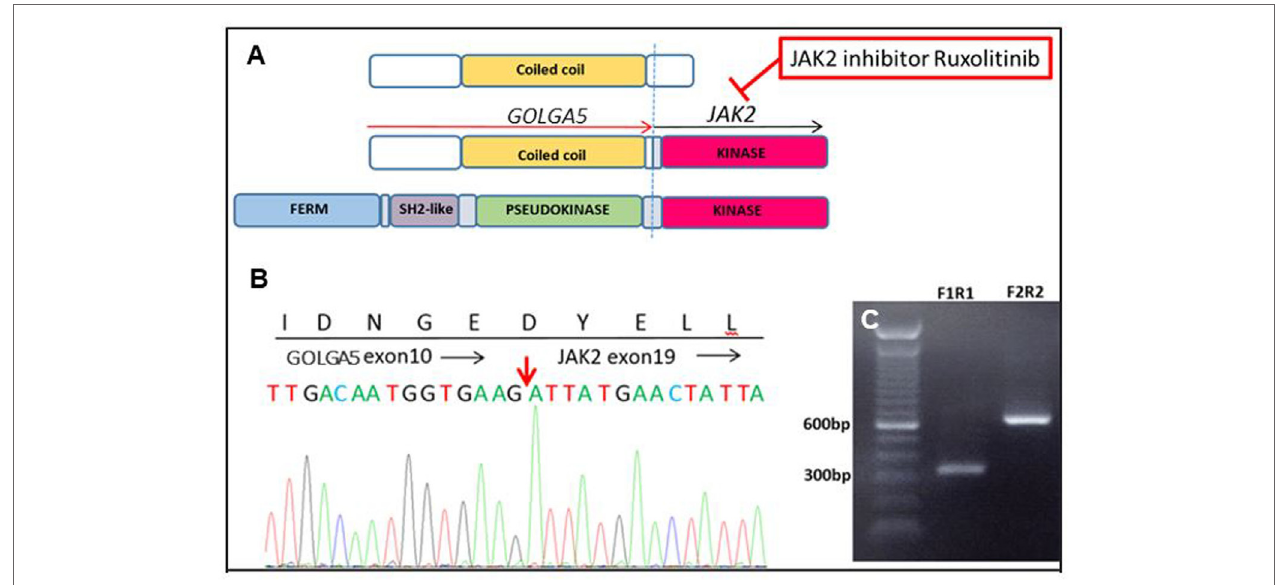
FiGUre 2 | A novel GOLGA5–JAK2 fusion was identified in an 11-year-old boy with very high-risk acute lymphoblastic leukemia. (A) Schematic representation of protein domains of the GOLGA5–JAK2 fusion protein. (b) Sanger confirmation of the GOLGA5–JAK2 fusion. The red arrow indicates the breakpoint of the fusion transcript. (c) Gel electrophoresis of nested polymerase chain reaction (PCR) products from the diagnostic bone marrow sample; F1R1—PCR product of inner forward and reverse primers; F2R2—PCR product of outer forward and reverse